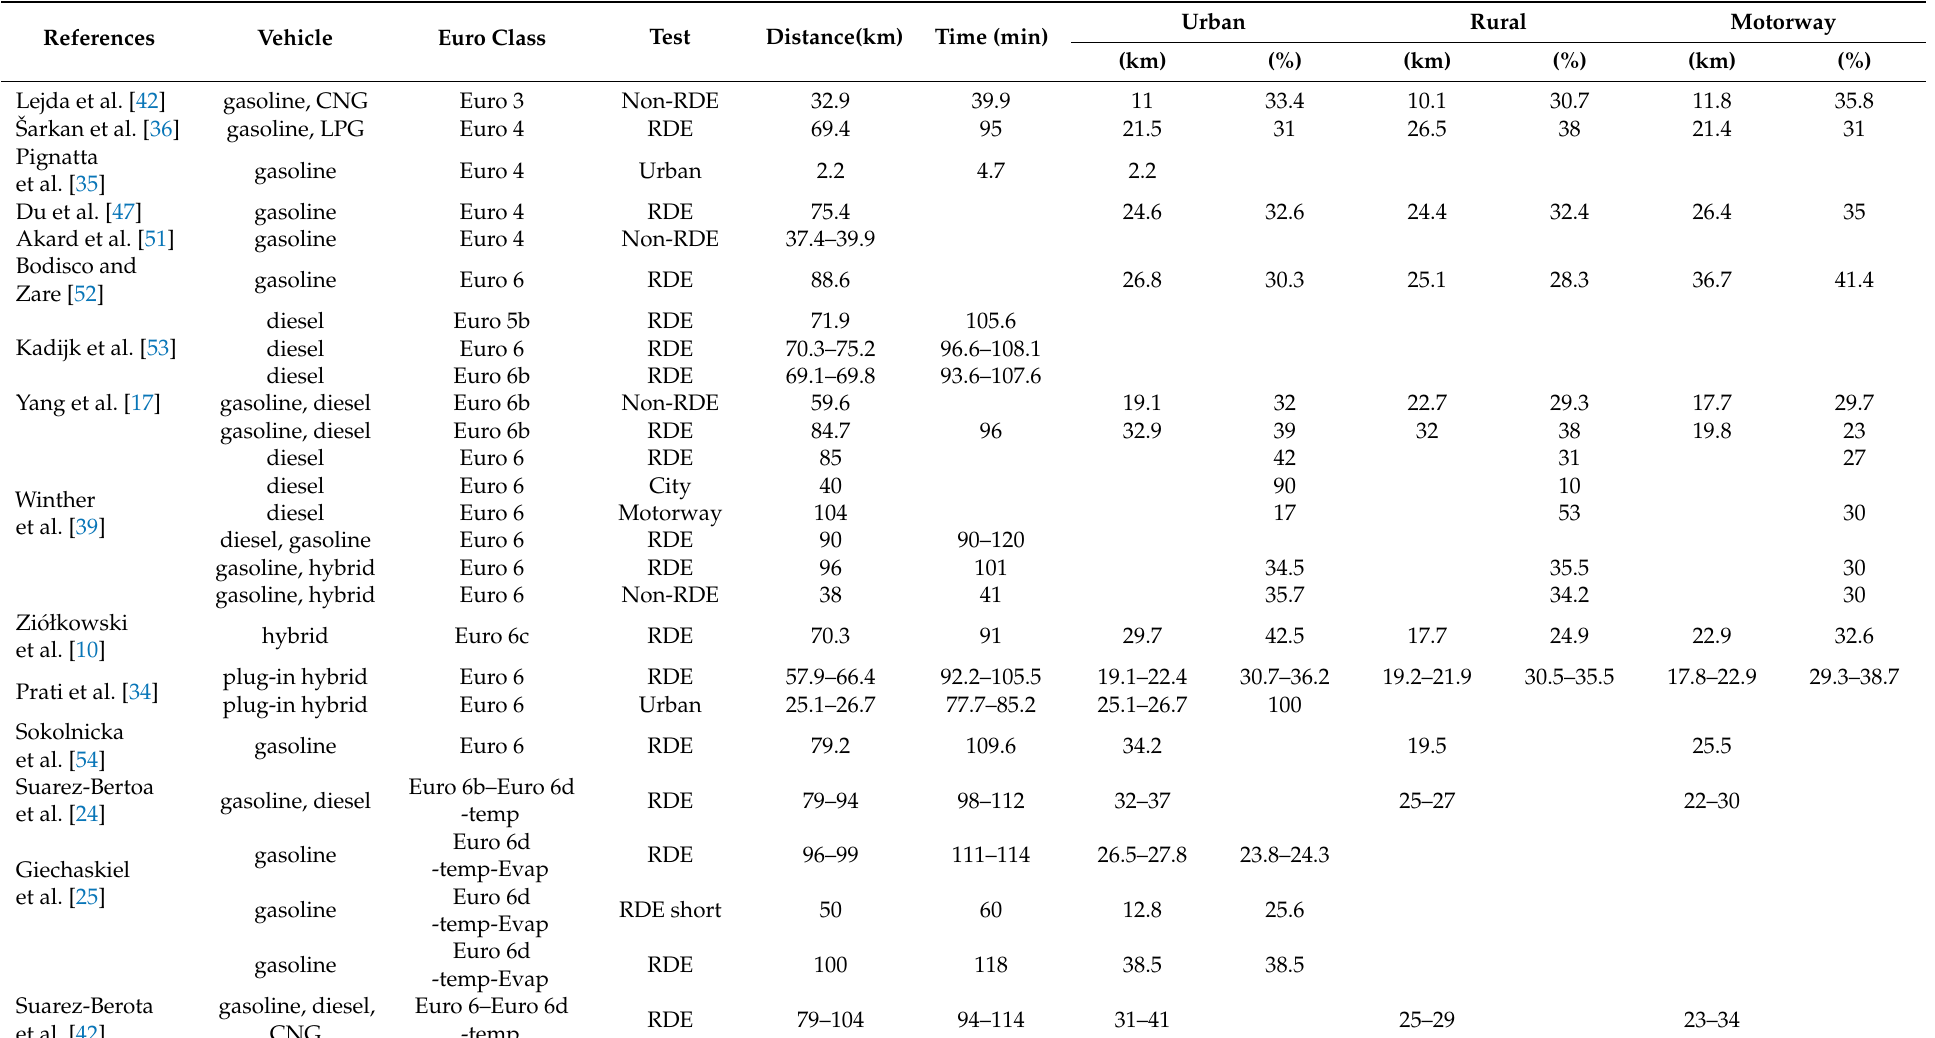
Table 1. Characteristics of research routes used in the research of various